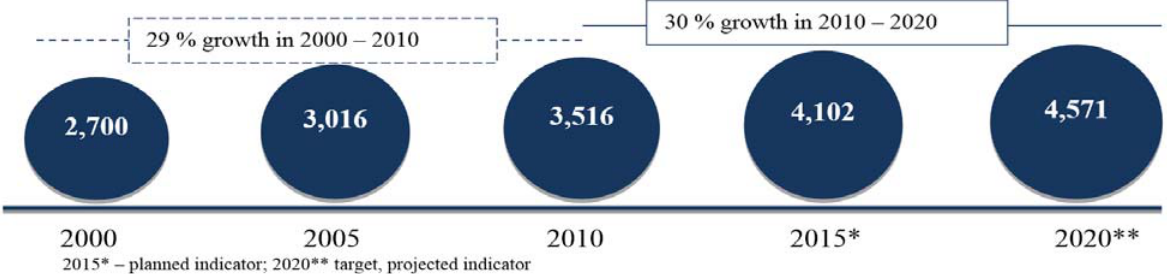
Fig 1. Global hydropower dynamics and tendencies, TWh (adapted by the author from Tracking Clean Energy Progress,